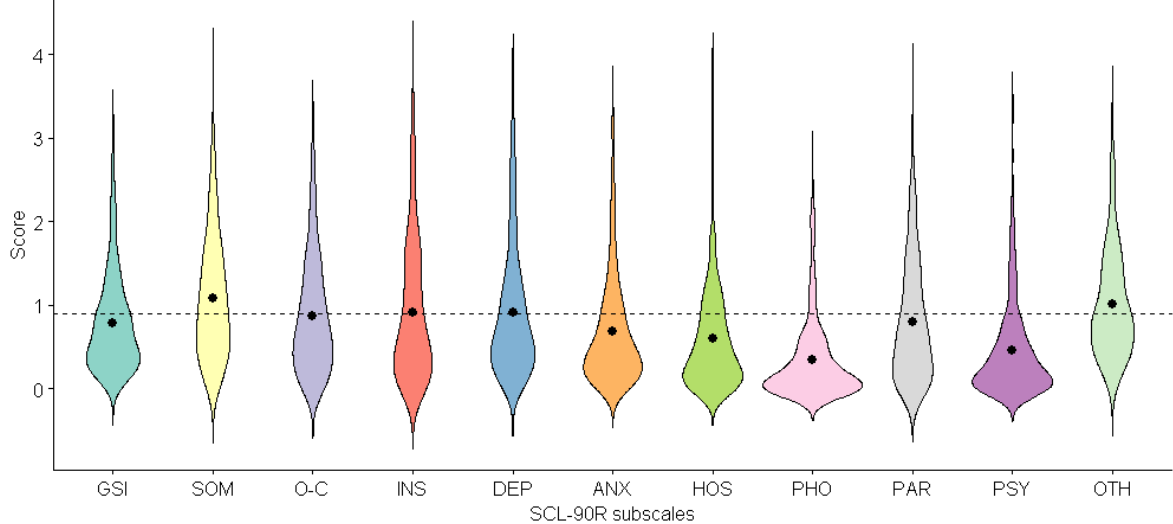
Figure 1. The SCL-90-R scores for obese patients who were eligible for bariatric surgery (distribution and mean values): GSI, Global Severity Index; SOM, somatization; O-C, obsessive–compulsive; INS, interpersonal sensibility; DEP, depression; ANX, anxiety; HOS, hostility; PHO, phobic anxiety; PAR, paranoidal ideation; PSY, psychoticism; OTH, other symptoms (additional items).